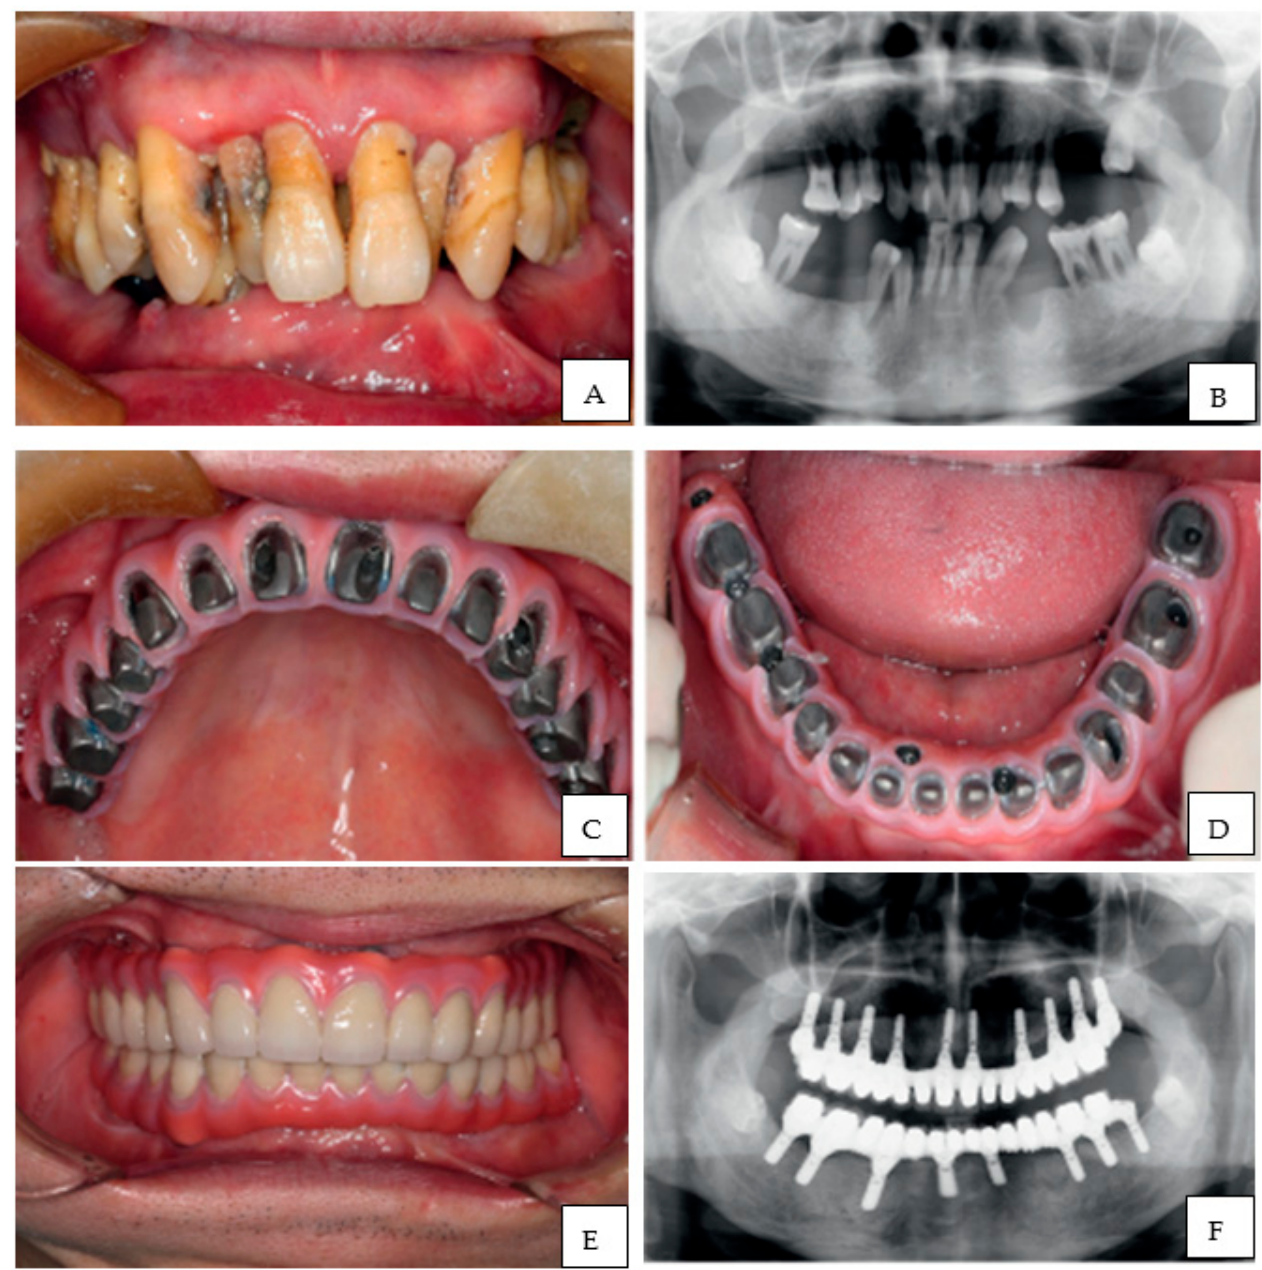
Figure 4. ( A ) Pre-operative condition- Intra-oral, ( B ) Panoramic radiograph, ( C , D ) Screw retained framework, maxillary and mandibular respectively, ( E ) Intraoral view of definitive prosthesis in place, ( F ) Panoramic radiograph after treatment. Images re-printed with permission from Wang et al. [119].